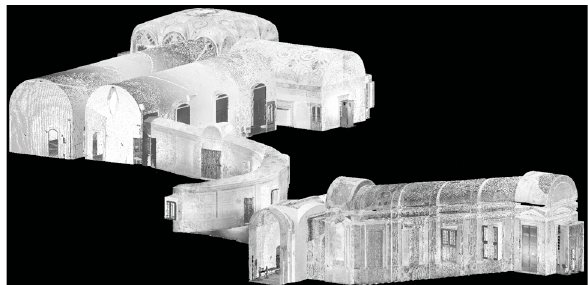
Figure 10. Point clouds of the path from the Scalone di Enea to the Camera degli Sposi